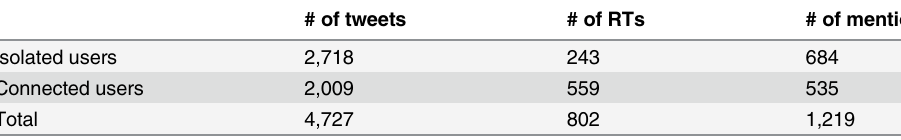
Table 3. Statistics for the isolated and connected Twitter users. # of tweets # of RTs # of